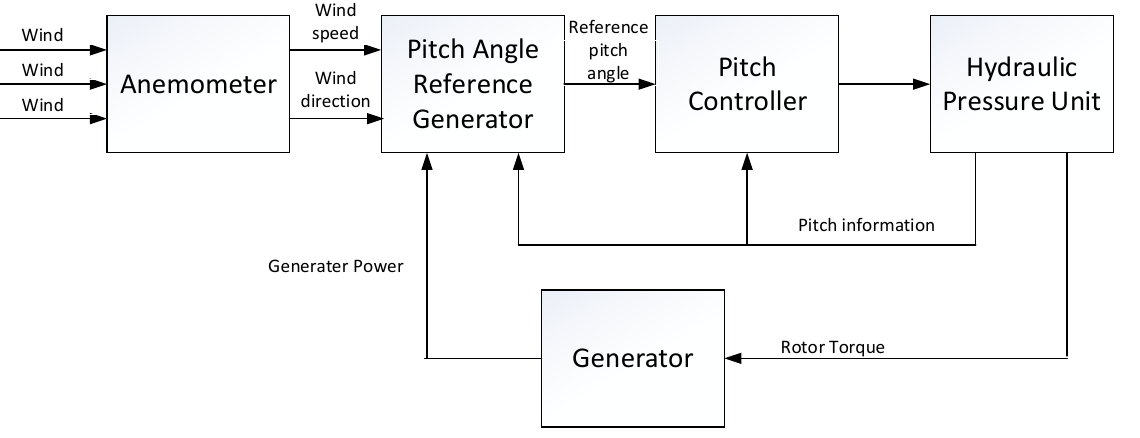
Figure 1. Control architecture of a large wind turbine.